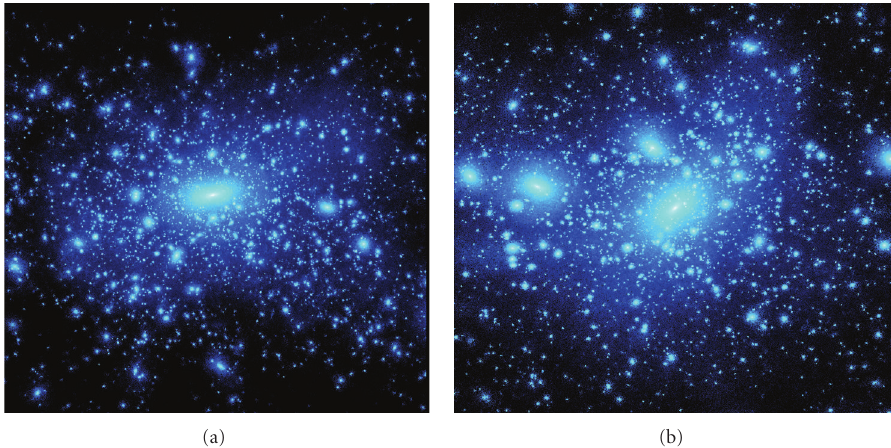
Figure 2: Comparison of two z = 0 halos of masses 3 × 10 14 M (cid:4) and 3 × 10 12 M (cid:4) formed in flat Λ CDM cosmology ( Ω m = 1 − Ω Λ = 0 . 3, h = 0 . 7, σ 8 = 0 . 9). In each case the mass distribution around the center of the halo is shown to approximately two virial radii from the center of each halo. Both objects were resolved with similar number of particles and similar spatial resolution relative to the virial radius of the halo in their respective simulations. I leave it as an exercise to the reader to guess the mass of the halo shown in each